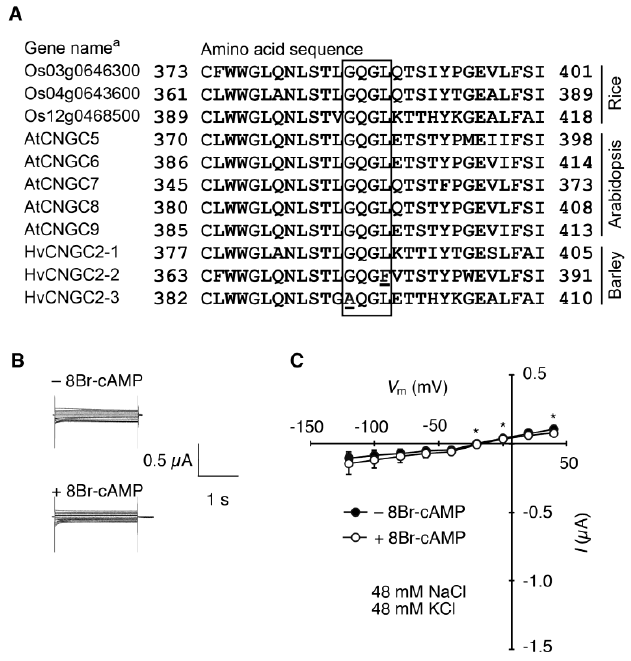
Figure 7. Alignment of deduced amino acid sequences of the putative ion-selective pore-forming motif (G/AQGL) of group-II CNGSs and voltage-clamp analysis of oocytes expressing HvCNGC2-3A394G . ( A ) the ion-selective motif is highlighted by box. Numbers indicate the amino acid